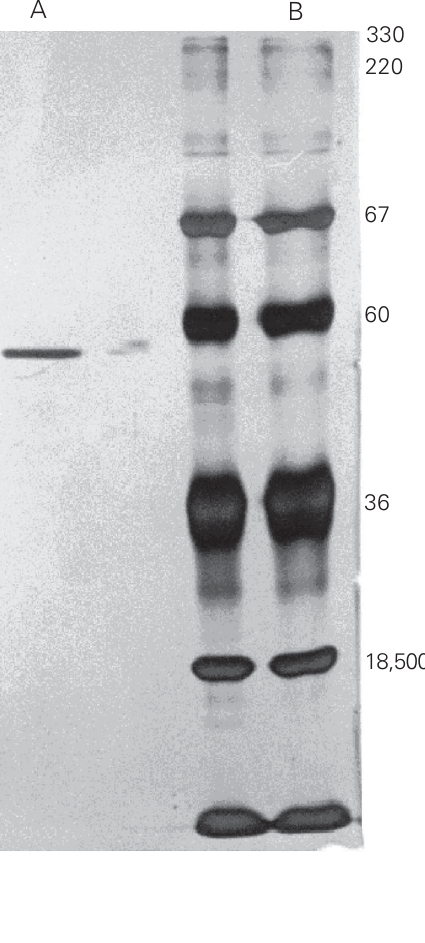
Figure 2. Analysis of Serratia marcescens cytotoxin by SDS- PAGE using silver staining. Lane A , Cytotoxic fraction obtained from a Sephadex G100 column (30 µg/ml); lane B , molecular weight markers.